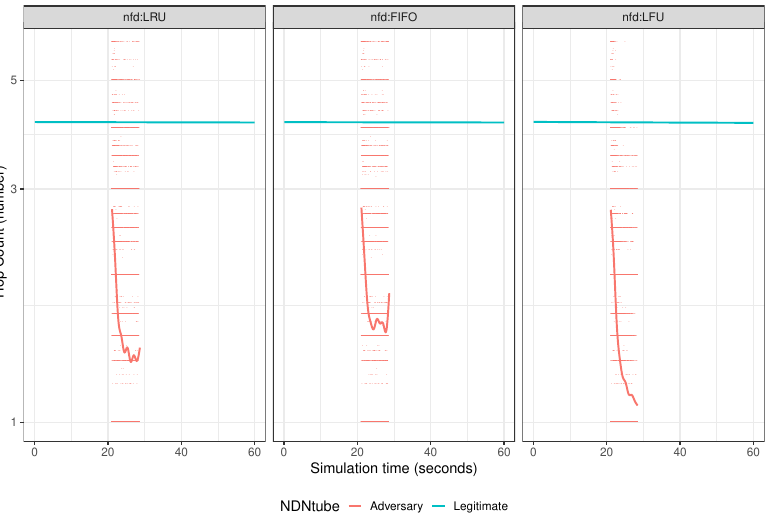
Figure 14. NDNtube global hop